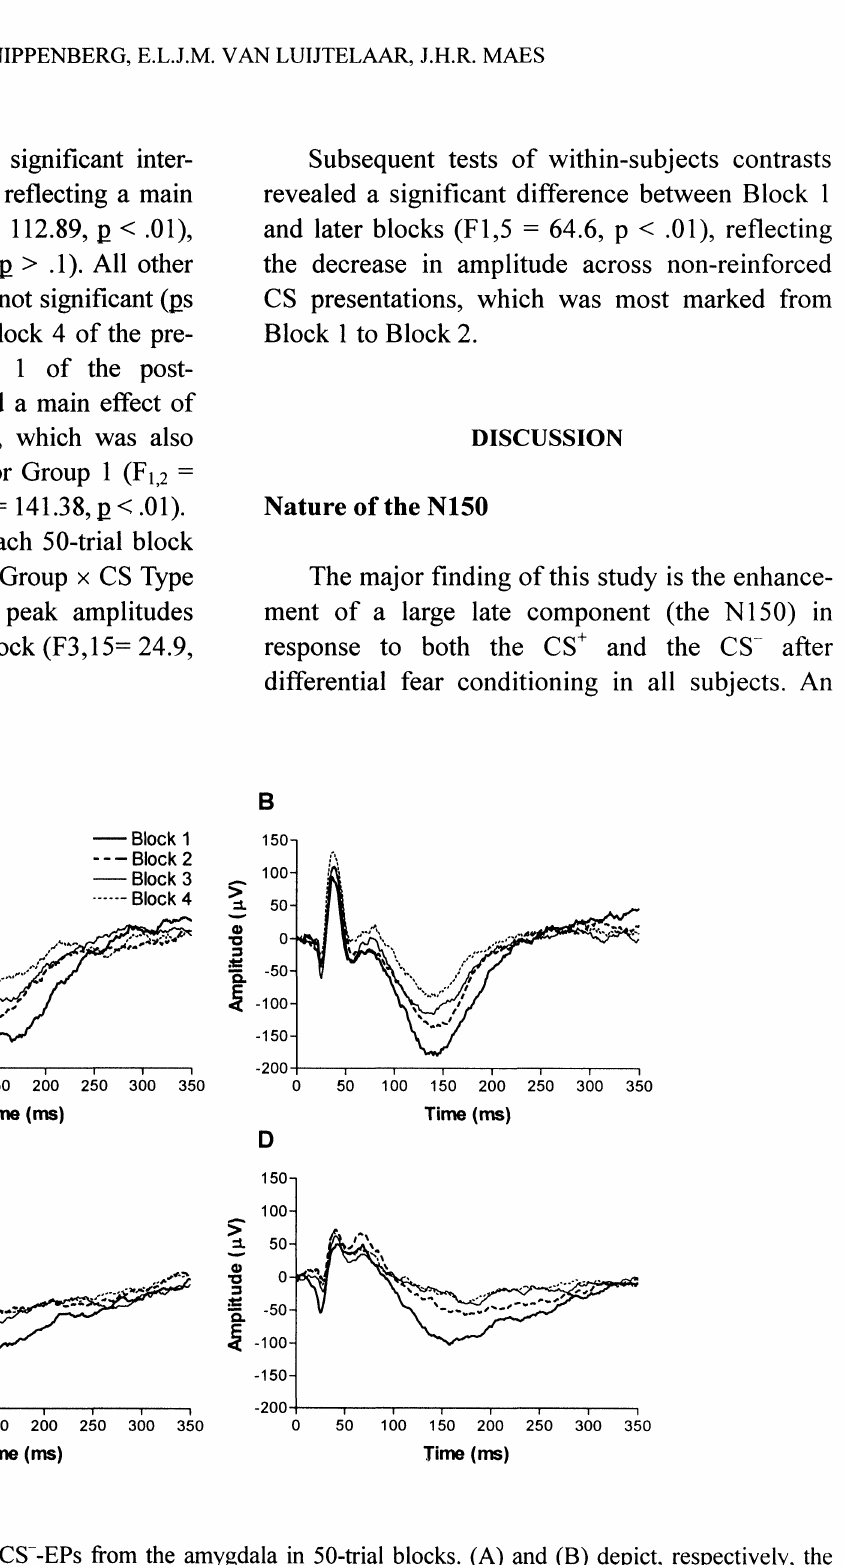
+- and CS--EPs from the amygdala in 50-trial blocks. (A) and (B) depict, respectively, the Fig. 4" Post-conditioning CS CS +- and CS--EPs of Group (n 3). (C) and (D) depict, respectively, the CS +- and CS--EPs of Group 2 (n